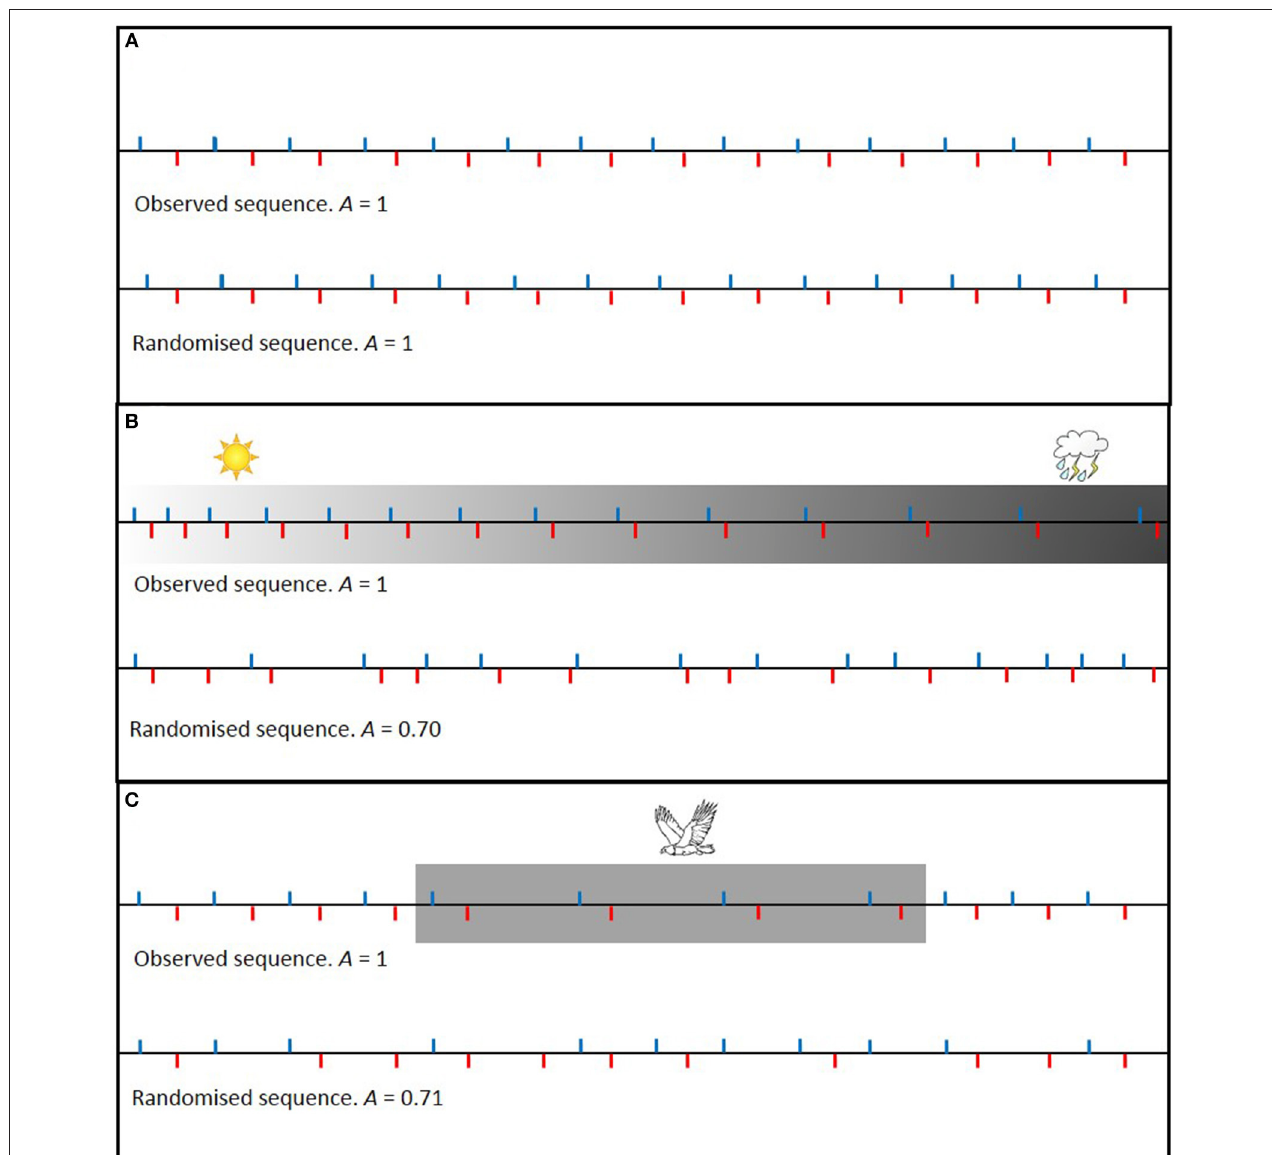
FIGURE 1 | Schematic examples of how randomizing the order of inter-visit intervals affects the level of alternation (A). A = F / ( t − 1), where F is the number of visits that was followed by a visit of the other parent and t is the total number of visits during the observation period (Bebbington and Hatchwell, 2016). Blue ticks indicate a nest visit by parent 1 and red ticks indicate a nest visit by parent 2. For the purpose of illustration, we assume that both parents make the same number of nest visits during the observation period and that the amount of time needed between visits is the same for every feeding trip (unless affected by external stimuli). In (A) visit rates do not change over time and randomization does not affect the level of alternation. In (B,C) however, inter-visit intervals of both parents change in the same way over time, e.g., due to deteriorating weather conditions or due to the presence of a predator, and randomization of the inter-visit intervals leads to a reduced level of